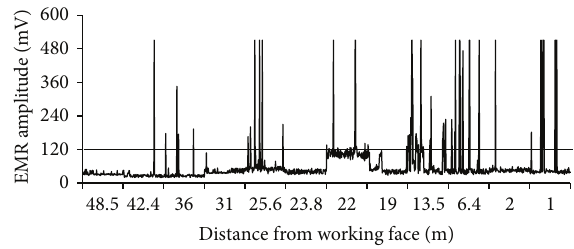
Figure 13: EMR amplitude variation in tailentry at the stage of first periodic caving. Note: the caving interval is 20 m, and the pressuring intensity is not obvious according to in situ observation of roadway